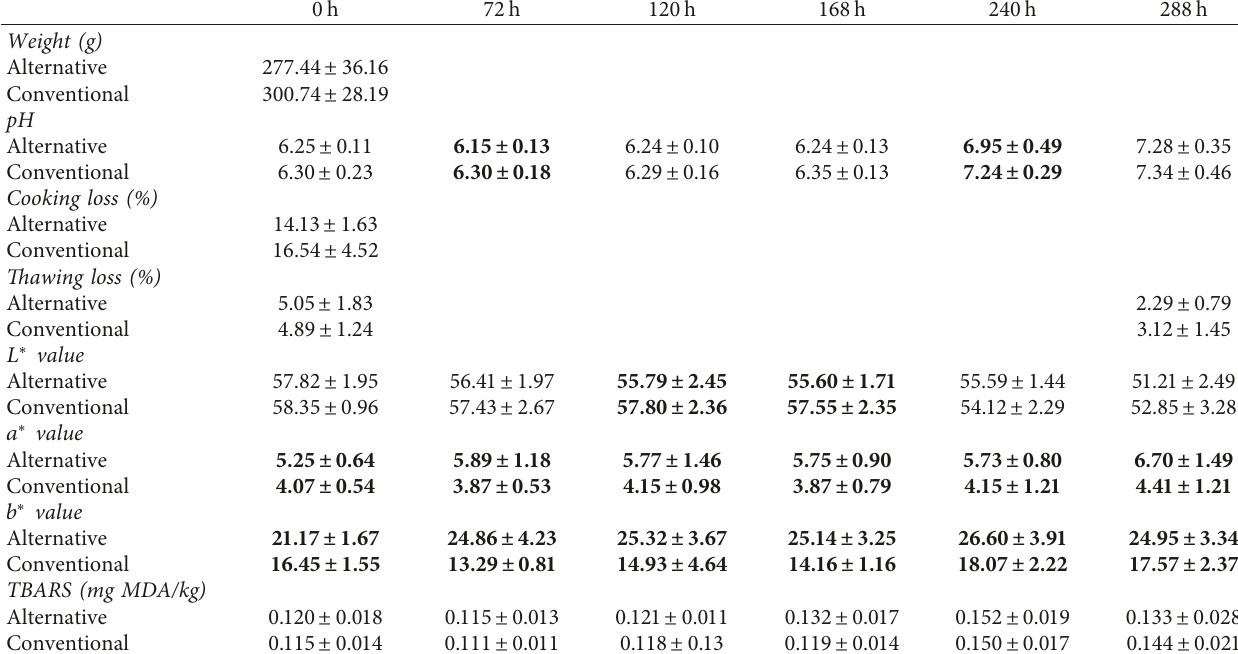
Table 2: Mean values and standard deviations of investigated meat quality parameters during storage (alternative: n point; conventional: n 13 per investigation point). (cid:31)